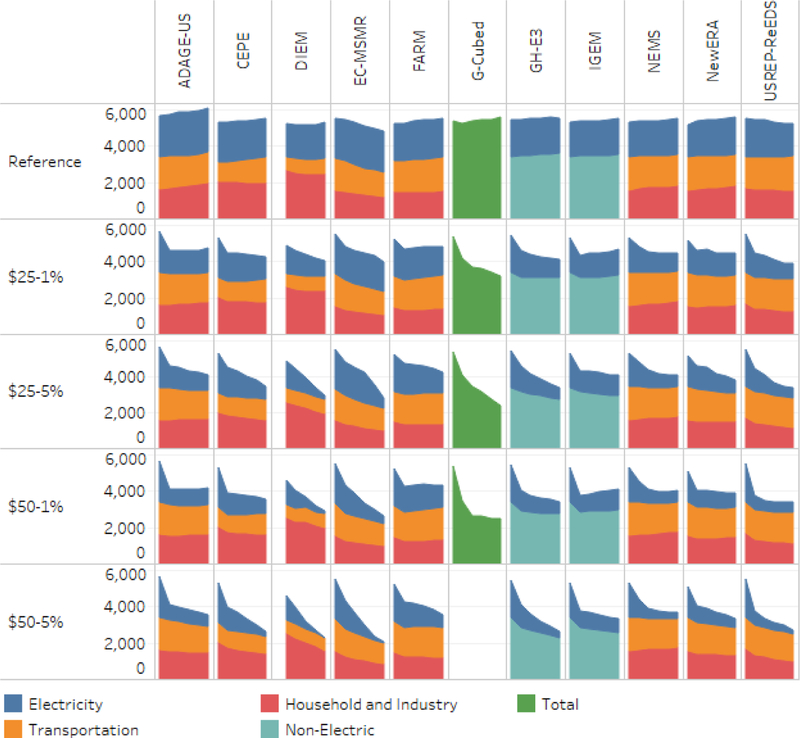
CO2 emissions in MMTCO2 by sector with household rebates, 2015–2040.